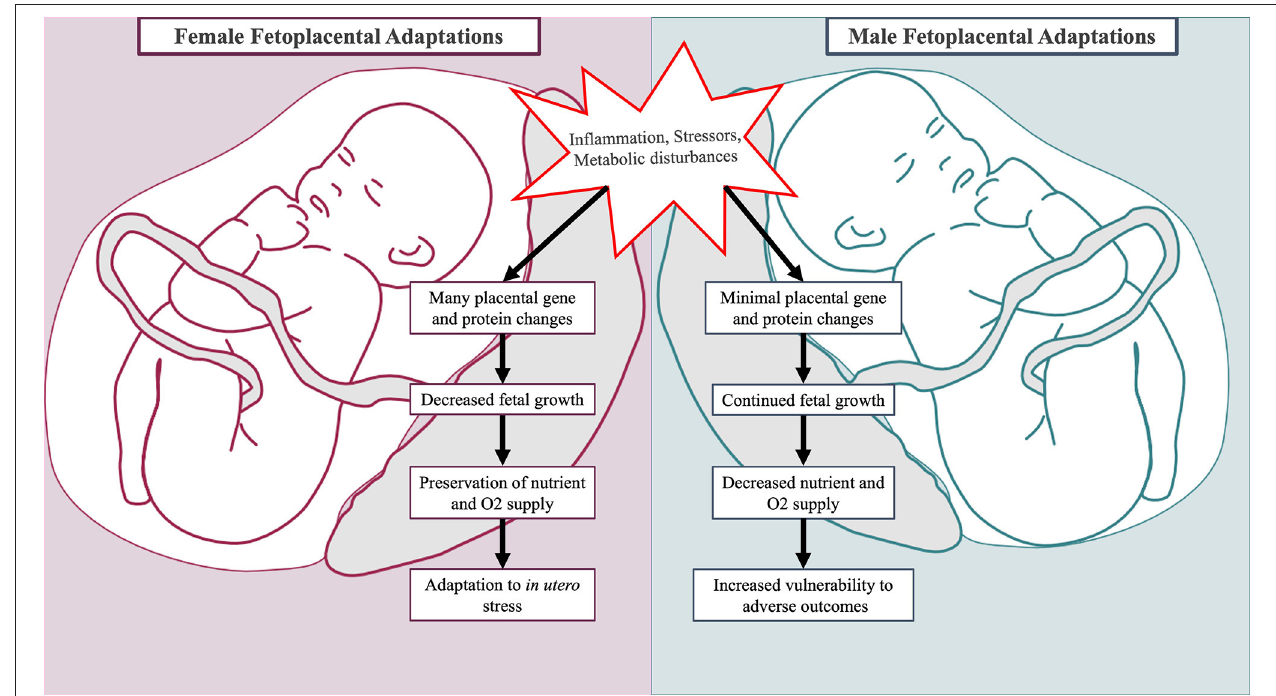
FIGURE 2 | Sex-specific fetal and placental adaptations to maternal adversity. Placentas of male and female fetuses respond differently to mild forms of maternal adversity. In the placenta of female fetuses, multiple changes in glucocorticoid barrier enzyme activity, gene expression, and protein synthesis occur leading to decreased growth ( 176, 177). This is advantageous as it preserves fetal oxygen and nutrient delivery. In the placenta of male fetuses, minimal changes in gene and protein expression occur, and the male fetus continues to grow incurring increased vulnerability to adverse outcomes